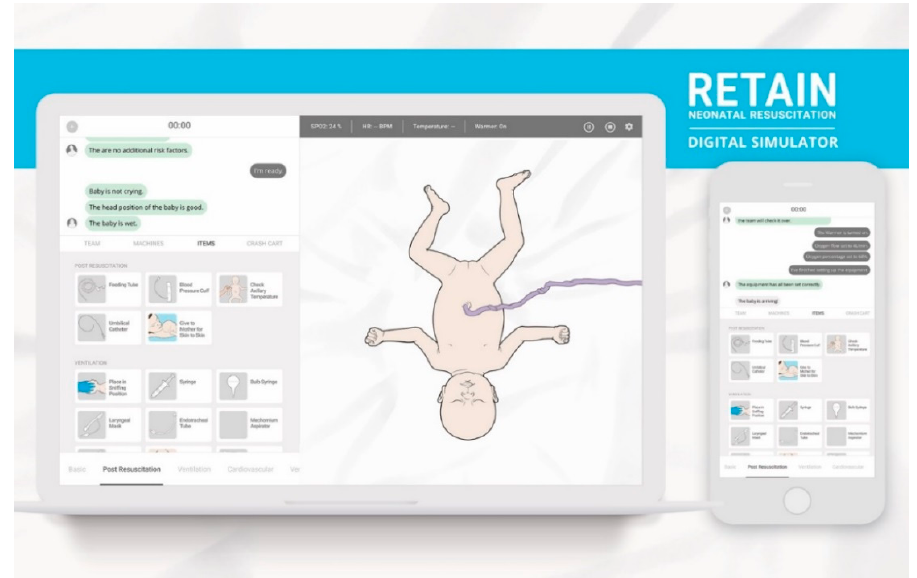
Figure 2. The RETAIN computer game digital training simulator. Permission for reprint obtained from Retain Labs Medical Inc. Available online: https://playretain.com (accessed on 30 November 2019) [12].